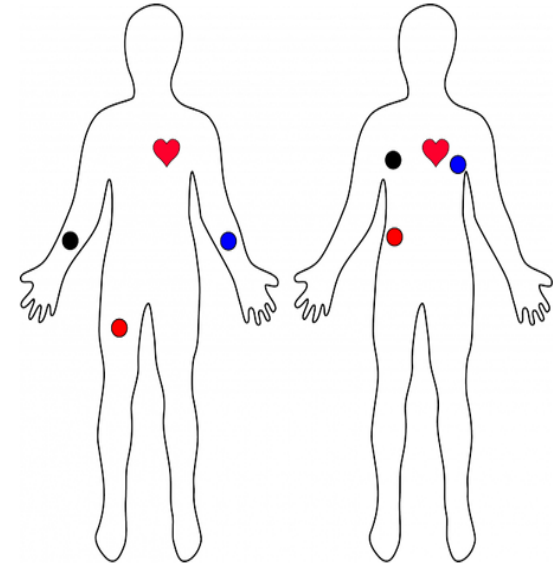
Figure 2. The typical position of sensor pads on the human body Table 5. Correct electrodes position on the human